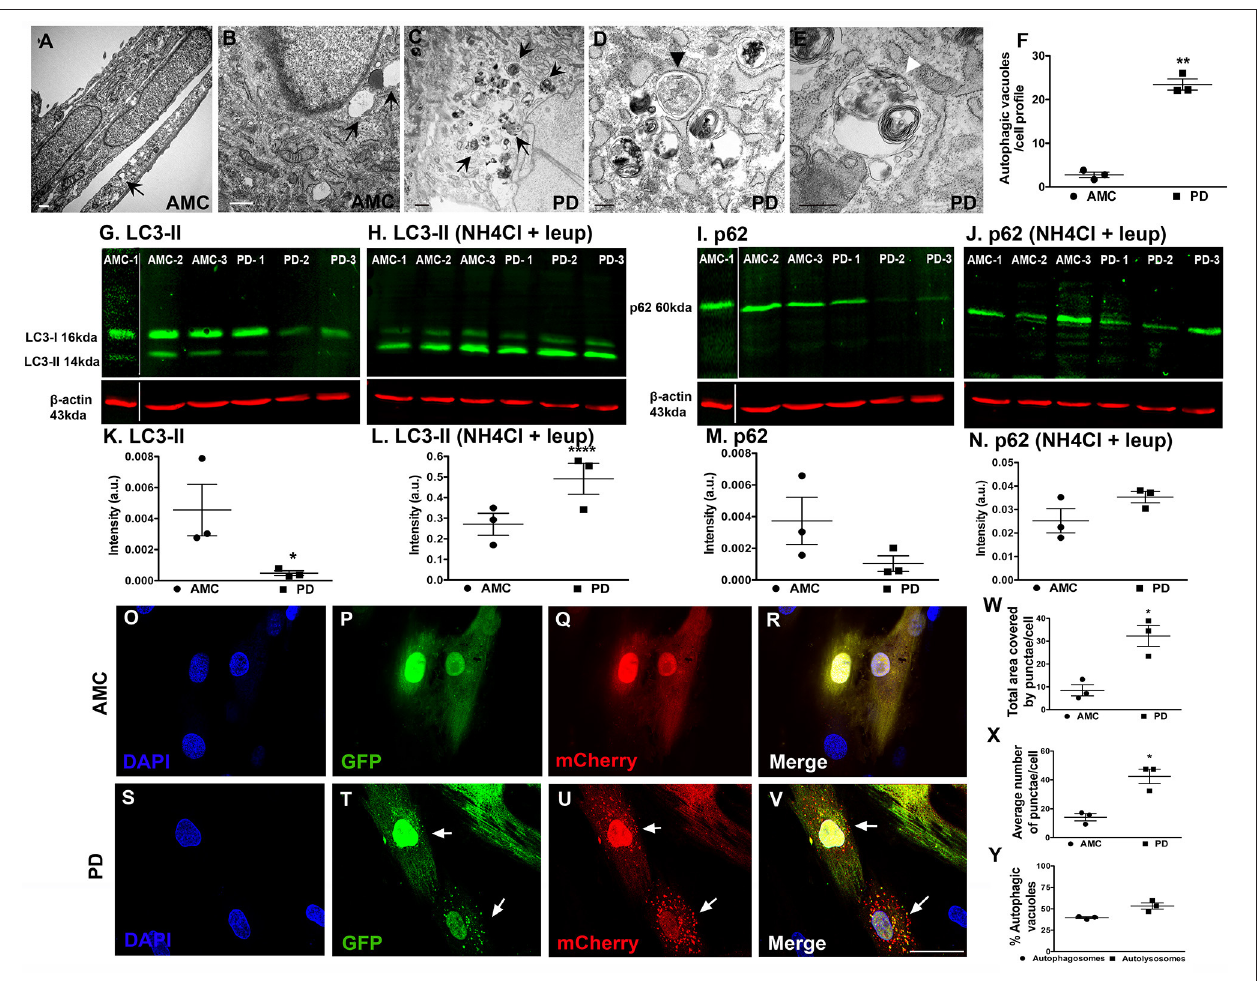
FIGURE 5 | Increased autophagy at baseline in PD fibroblasts. (A,B) (arrows) shows electron micrographs of AMC fibroblasts with some autophagic vesicles. However, PD fibroblasts contained significantly more autophagic vesicles ( C , arrows). A classic double-membrane autophagosome with cargo ( D , black arrowhead) and autolysosome with degradative material ( E , white arrowhead), as seen in a PD fibroblast. (F) shows EM quantification of autovesicles. Western blots showing significantly lower protein expression of autophagy marker LC3-II in PD fibroblasts (G,K) and p62 (I,M) at baseline. Normalization occurred to ß-Actin. LC3-II and p62 expression (flux) increased upon blocking of degradation via a combination of NH4Cl and Leupeptin in especially PD cell lines (H,L,J,N) . Fluorescence tracking of autophagic flux in Ad-mCherry-GFP-LC3 transfected AMC fibroblasts is shown in (O–V) with quantification in (W–Y) . Green puncta represent autophagosomes whereas red puncta represent autolysosomes. Scale Bars: (A–E) = 500nm, (O–V) = 50 µ m. * p < 0.05, ** p < 0.01, **** p < 0.0001; Mean ± SEM, Unpaired t- tests with Welch’s correction, n = 3 independent PD and AMC lines.